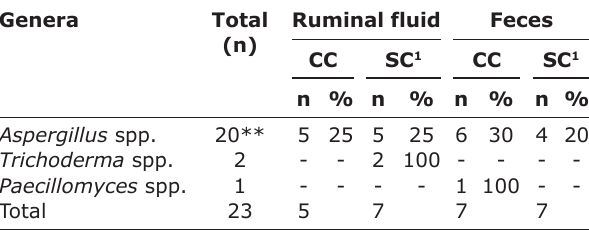
Table-5: Distribution of genera of mycelial fungi isolated from the ruminal fluid and feces of Nellore calves supplemented (SC) or not supplemented (CC) with ruminal fungi. Genera